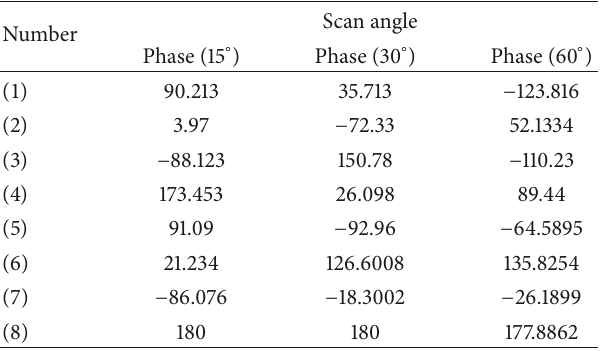
Table 1: Distribution of antenna array in